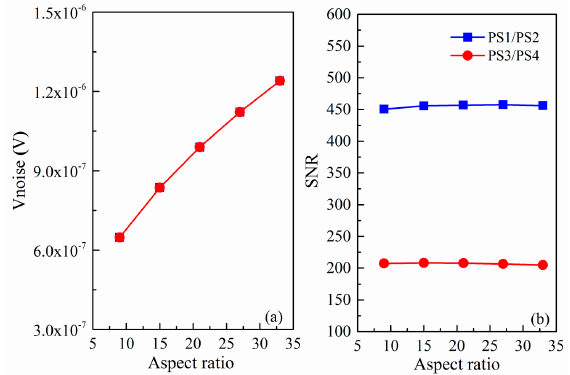
Figure 6. ( a ) Variation of the voltage noise with the aspect ratio; and ( b ) variation of SNR with the aspect ratio.